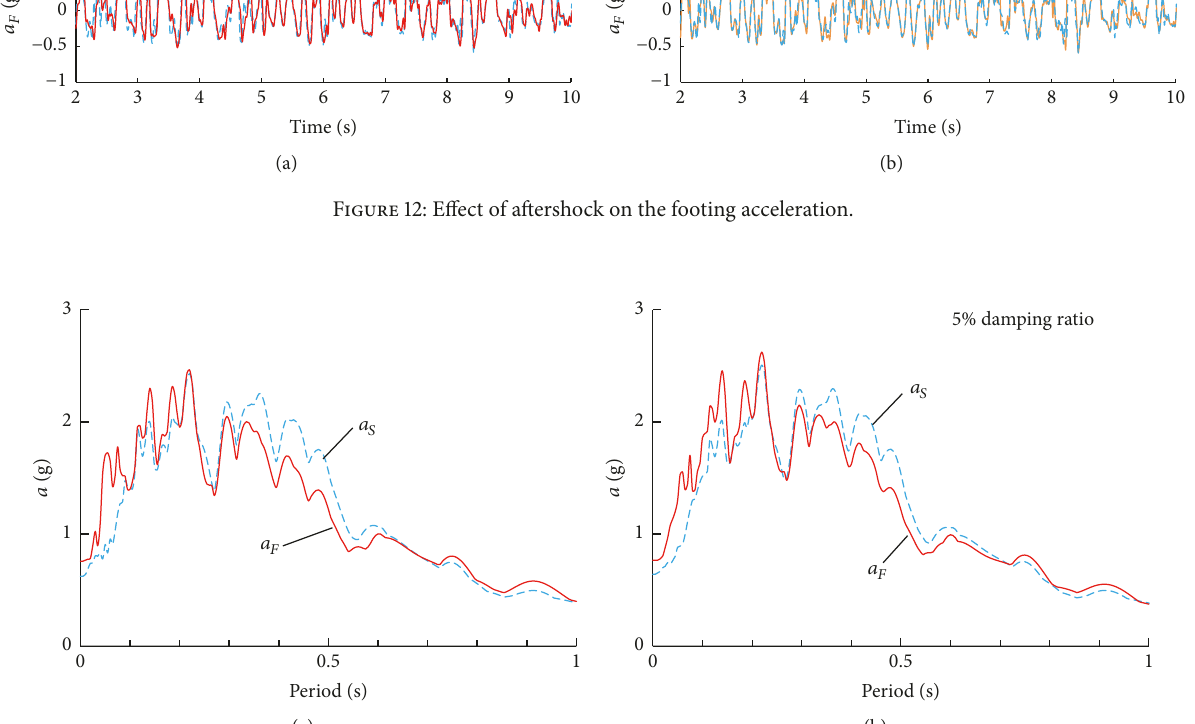
Figure 13: Response spectrum of soil and footing accelerations obtained from (a) the first aftershock and (b) the second aftershock.